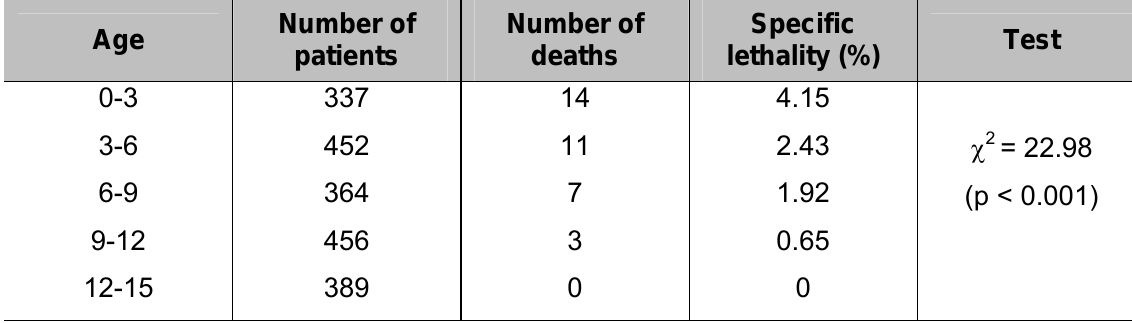
Table 4. Specific fatality rate according to age group